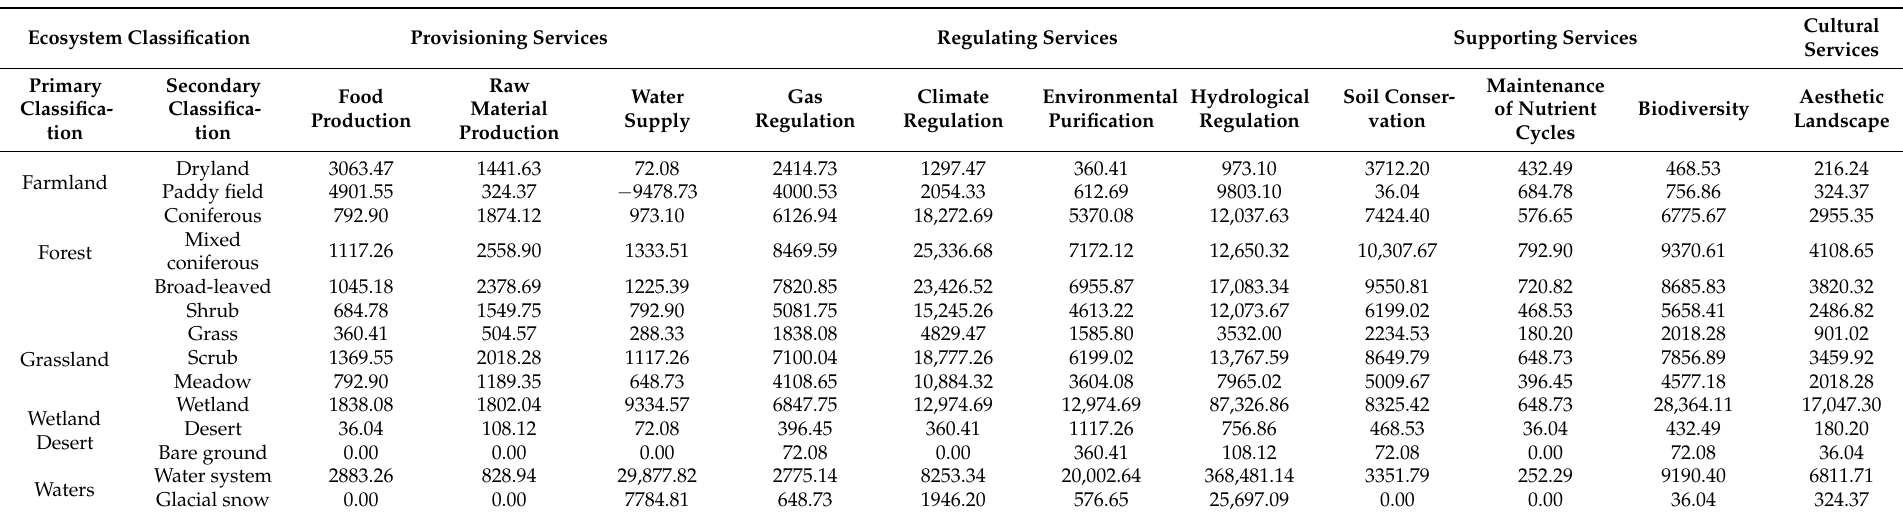
Table 1. Table of ecological service value per unit area of the secondary ecosystem in Poyang Lake basin (Yuan/hm 2 ).